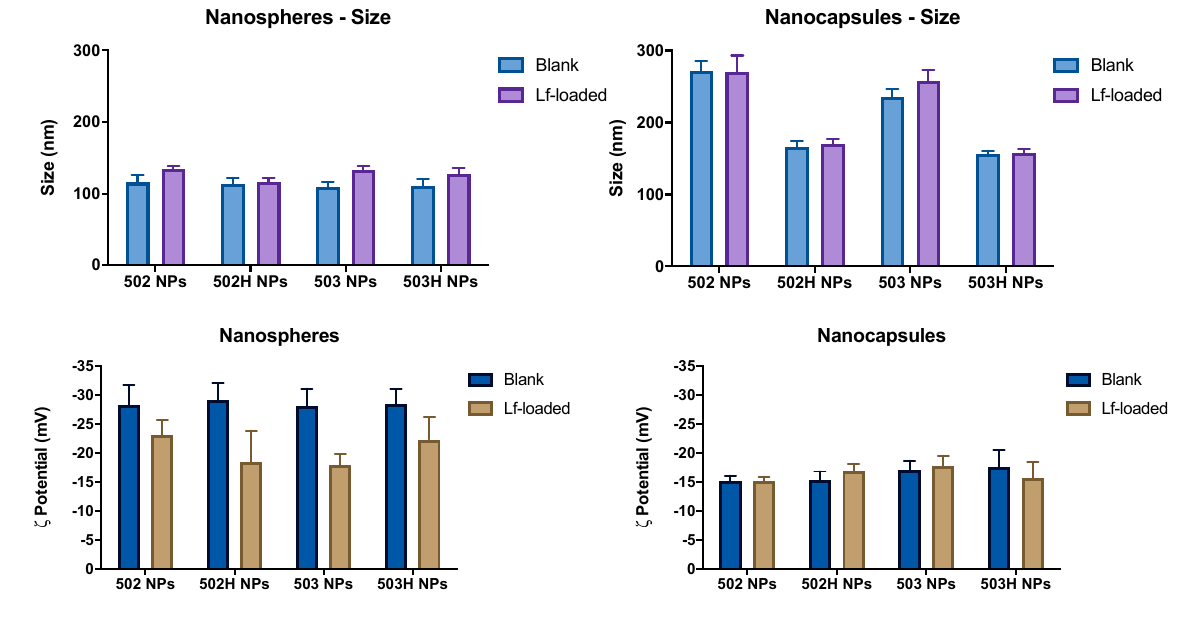
Figure 3. Comparison of size and ζ potential differences for blank and lactoferrin-loaded PLGA-based nanoparticles. A one-way ANOVA statistical analysis was applied, and no statistically significant differences were found among the formulations ( p > 0.05), regardless of the polymer used.